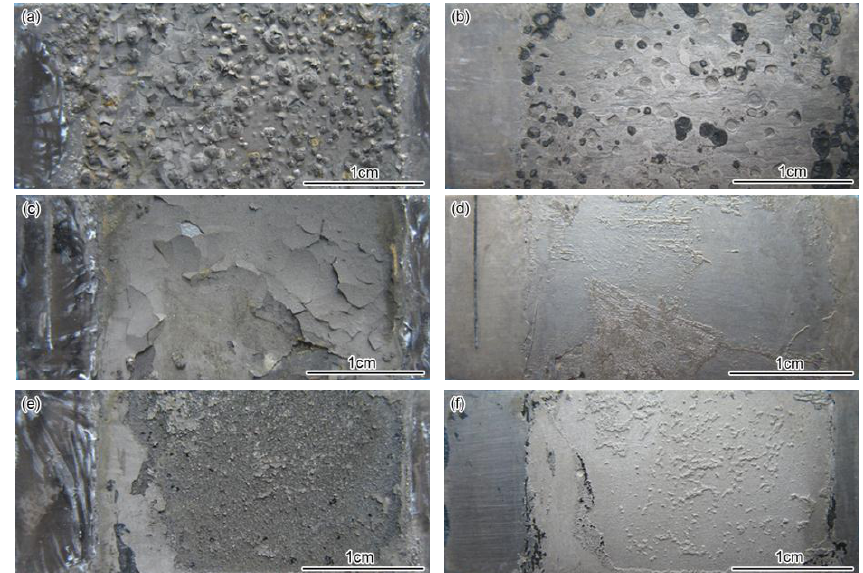
Figure 2. Macroscopic surface morphology of the tube steels before ( a , c , e ) and after ( b , d , f ) the removal of corrosion scales ( P CO2 = 5 MPa, P H2S = 0.2 MPa, 90 °C, 1 m/s, 360 h, 3.5 wt % NaCl): (a,b) P110; (c,d) 3Cr-P110 and (e,f) 5Cr-P110.